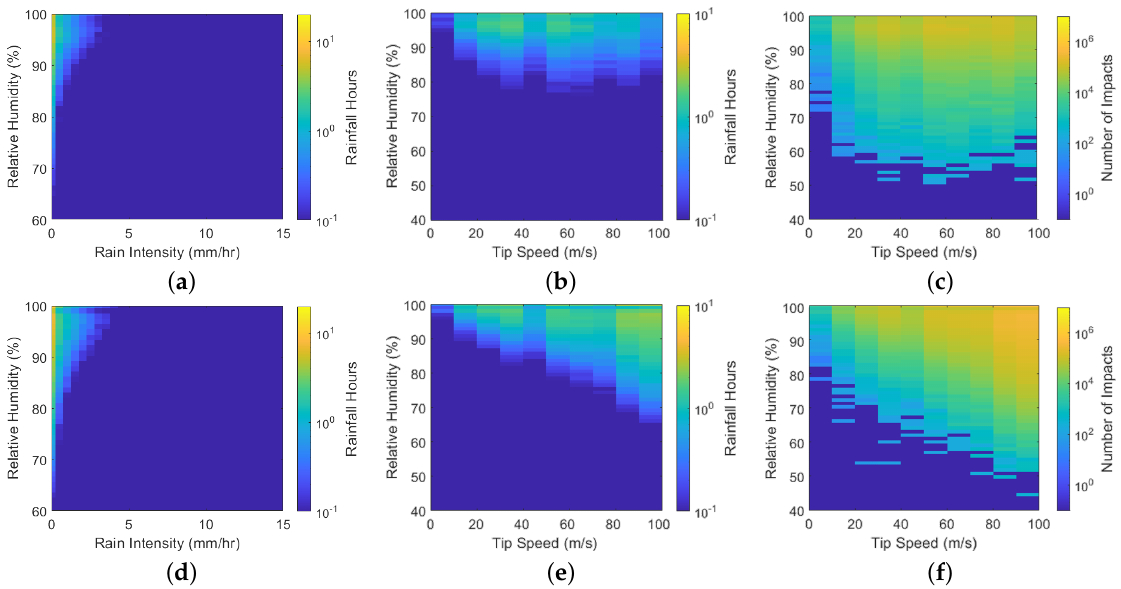
Figure 22. Average annual humidity/rainfall ( a , d ), humidity/rainfall/tip speed ( b , e ) and humidity/ n A /tip speed ( c , f ) distributions for July and December,